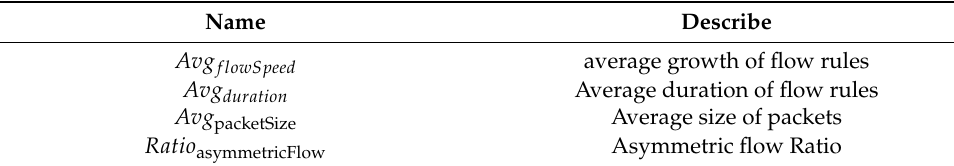
Table 2. Manually constructed statistical feature